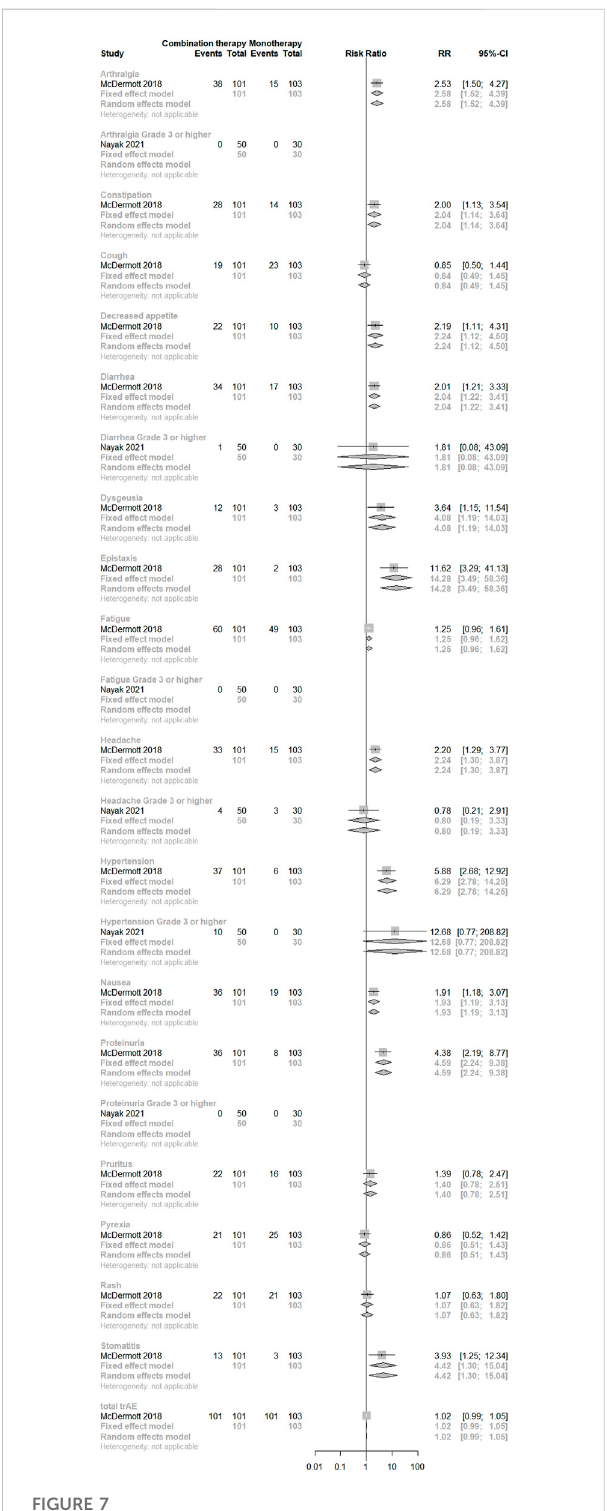
FIGURE 7 Direct comparisons of PD-(L)1 inhibitor monotherapy and in combination with anti-VEGF(R) agents therapy for